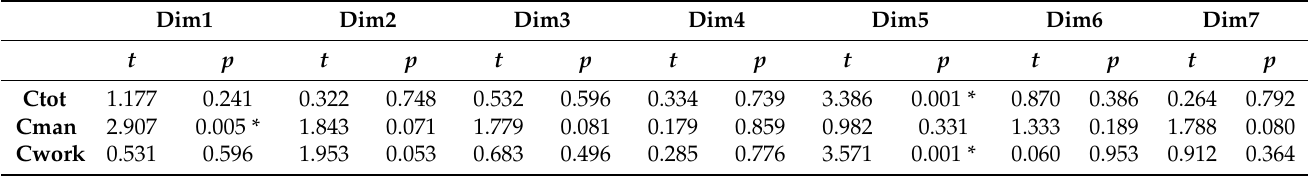
Table 9. Results of the t -test analyses related to the correlation between the NOSACQ-50 and COVID-19 questionnaires 1 . Dim1 Dim2 Dim3